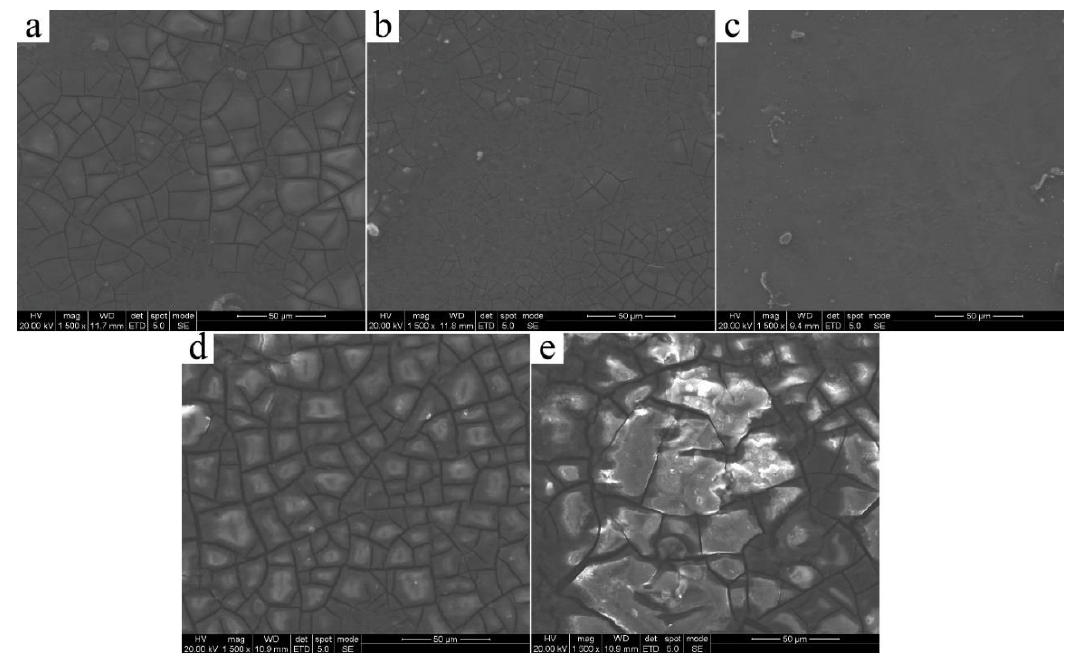
Figure 4. SEM corrosion surface morphologies of the SLMed Mg- x Mn ( a ) x = 0, ( b ) x = 0.4, ( c ) x = 0.8, ( d ) x = 1.2, ( e ) x = 1.6.